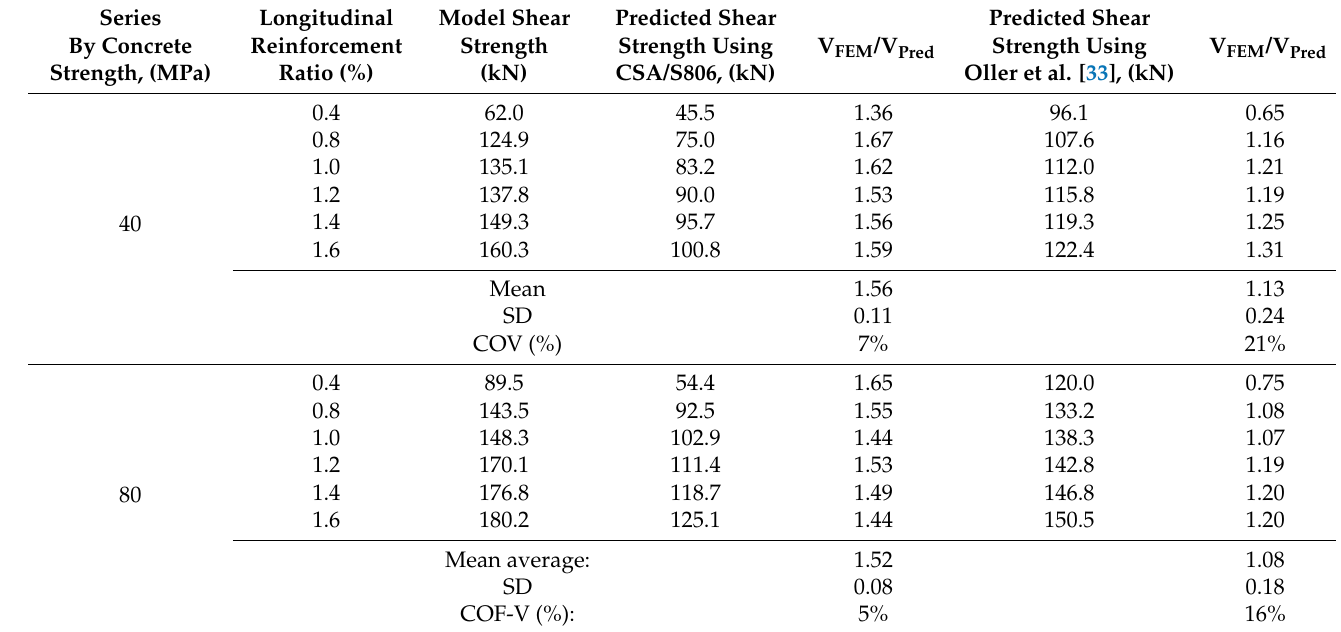
Table 6. FEM results and predicted shear strength for beam specimens of concrete strength 40 and 80 MPa with variable longitudinal reinforcement ratio. Series By Concrete Strength,